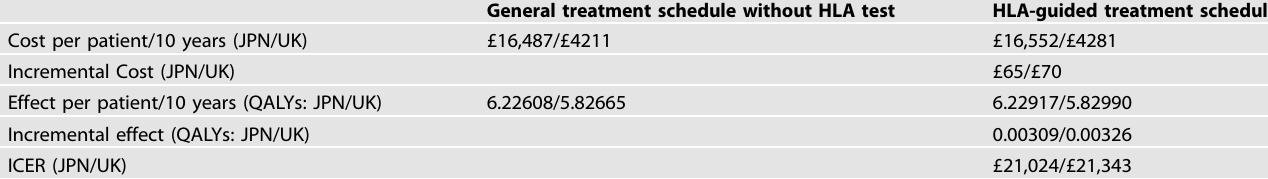
Table 1. Base – case scenario results.